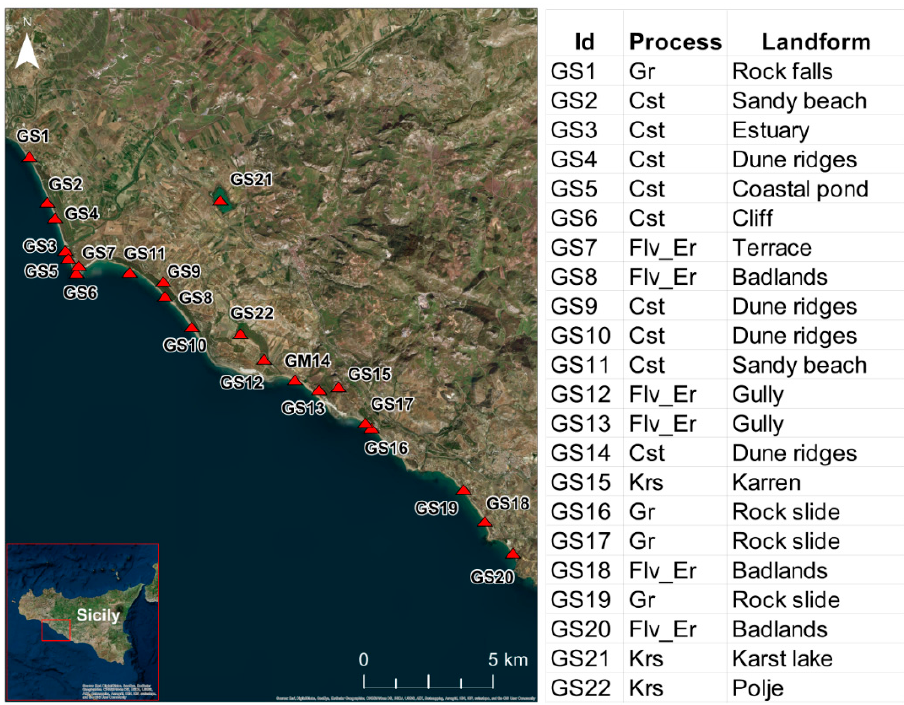
Figure 5. Geosites map of Sicily study area (GEOSIC) with the indication of the identification code, the predominant landforms (Gr: gravity-induced landforms, Cst: coastal landforms, Flv_Er: fluvial and water erosion landforms; Krs: karst landforms, Tct: tectonic landforms).